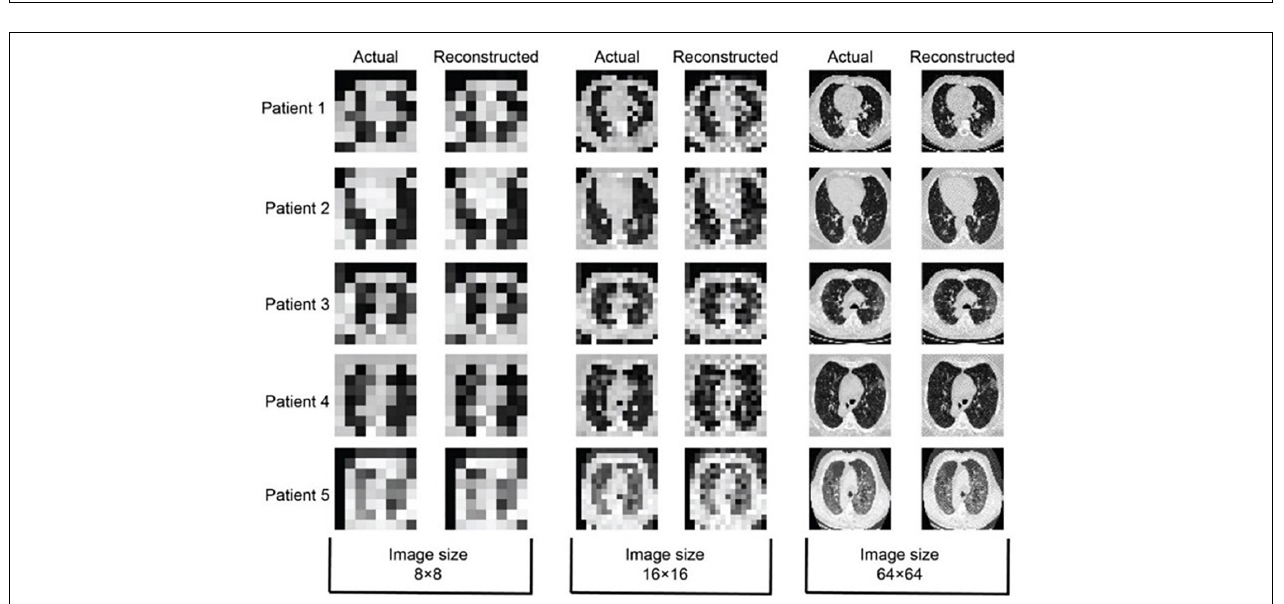
FIGURE 6 | Convergence trends as normalized error variation against annealing time for (A) 8 × 8, and (B) 16 × 16 ( N = 8 × 10 5 ) lung phantom reconstruction using fan beam projections.